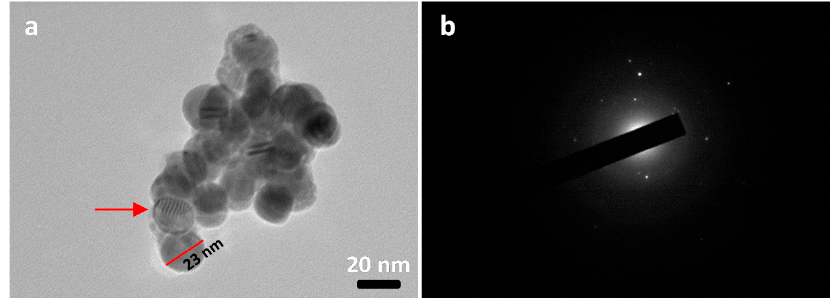
Figure 6. Representative transmission electron microscopy images of AgNP@P(PEG350) 3 ( a ) de- posited from water and the respective diffraction pattern ( b ).